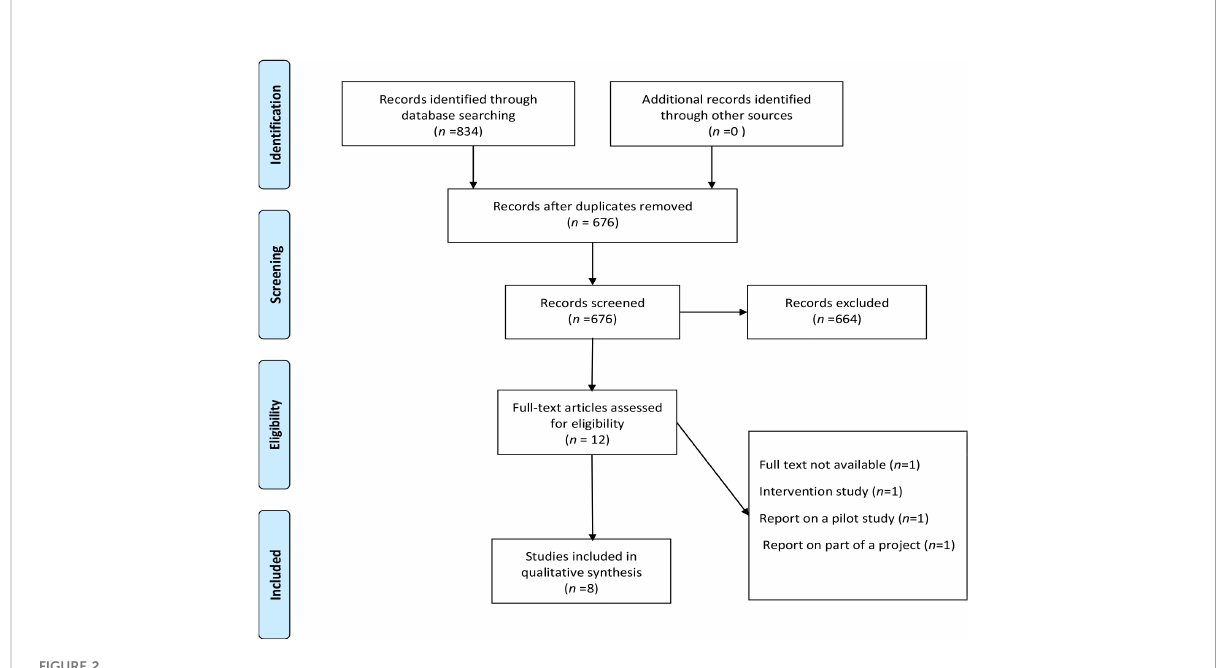
FIGURE 2 Stages of study